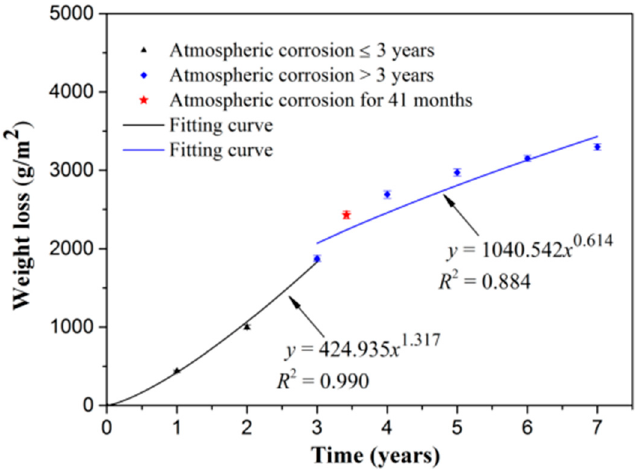
Figure 2. The mass loss of steel samples exposed to an urban industrial atmosphere versus the time in Taiyuan.